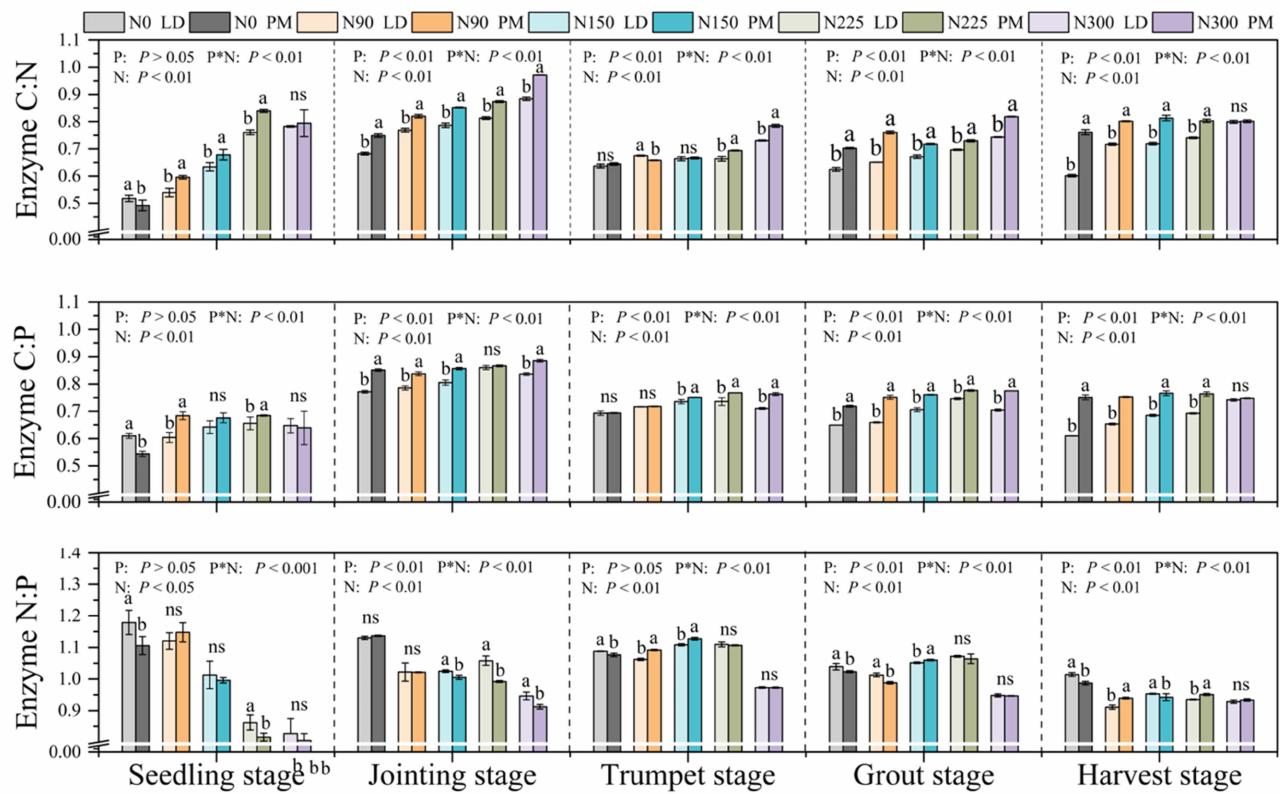
Figure 3. The stoichiometric ratio of soil enzyme activities under different nitrogen application levels under PM and LD treatments. P, plastic film mulching; N, nitrogen levels; P*N, plastic film mulching * nitrogen levels; N0, nitrogen application level was 0 kg · hm − 2 ; N90, nitrogen application level was 90 kg · hm − 2 ; N150, nitrogen application level was 150 kg · hm − 2 ; N225, nitrogen application level was indicate that there was significant difference between the PM and LD treatments at the same nitrogen level, and “ns” indicates that there was no significant difference between the PM and LD treatments at the same nitrogen